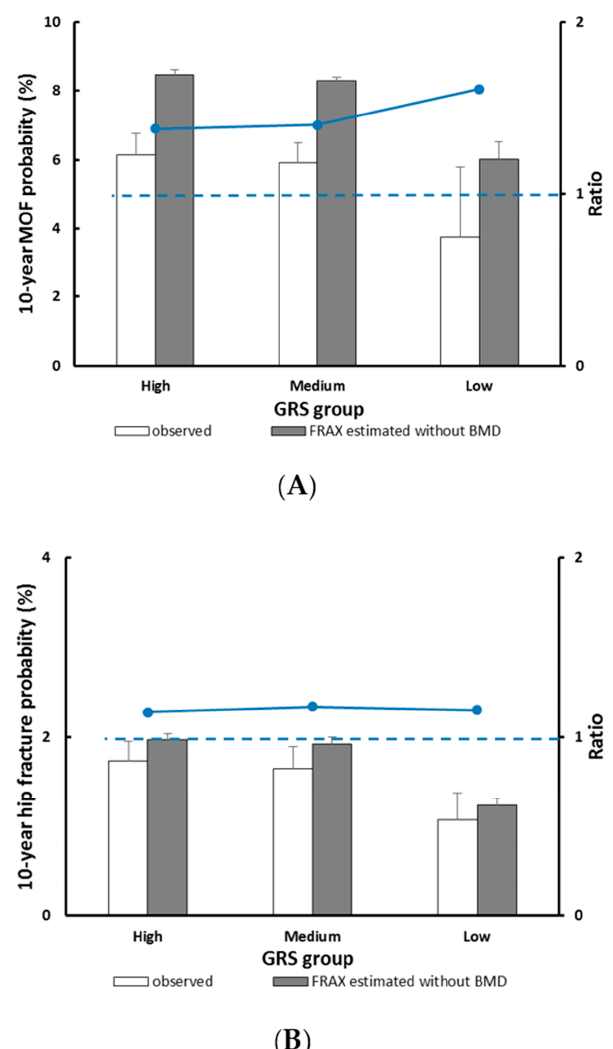
Figure 3. Observed versus predicted 10-year major osteoporotic fracture ( A ) and hip fracture ( B ) probability stratified by the GRS group. The dotted line indicates a relative ratio of 1 (reference line); ratio >1 indicates that FRAX overestimates fracture probability.